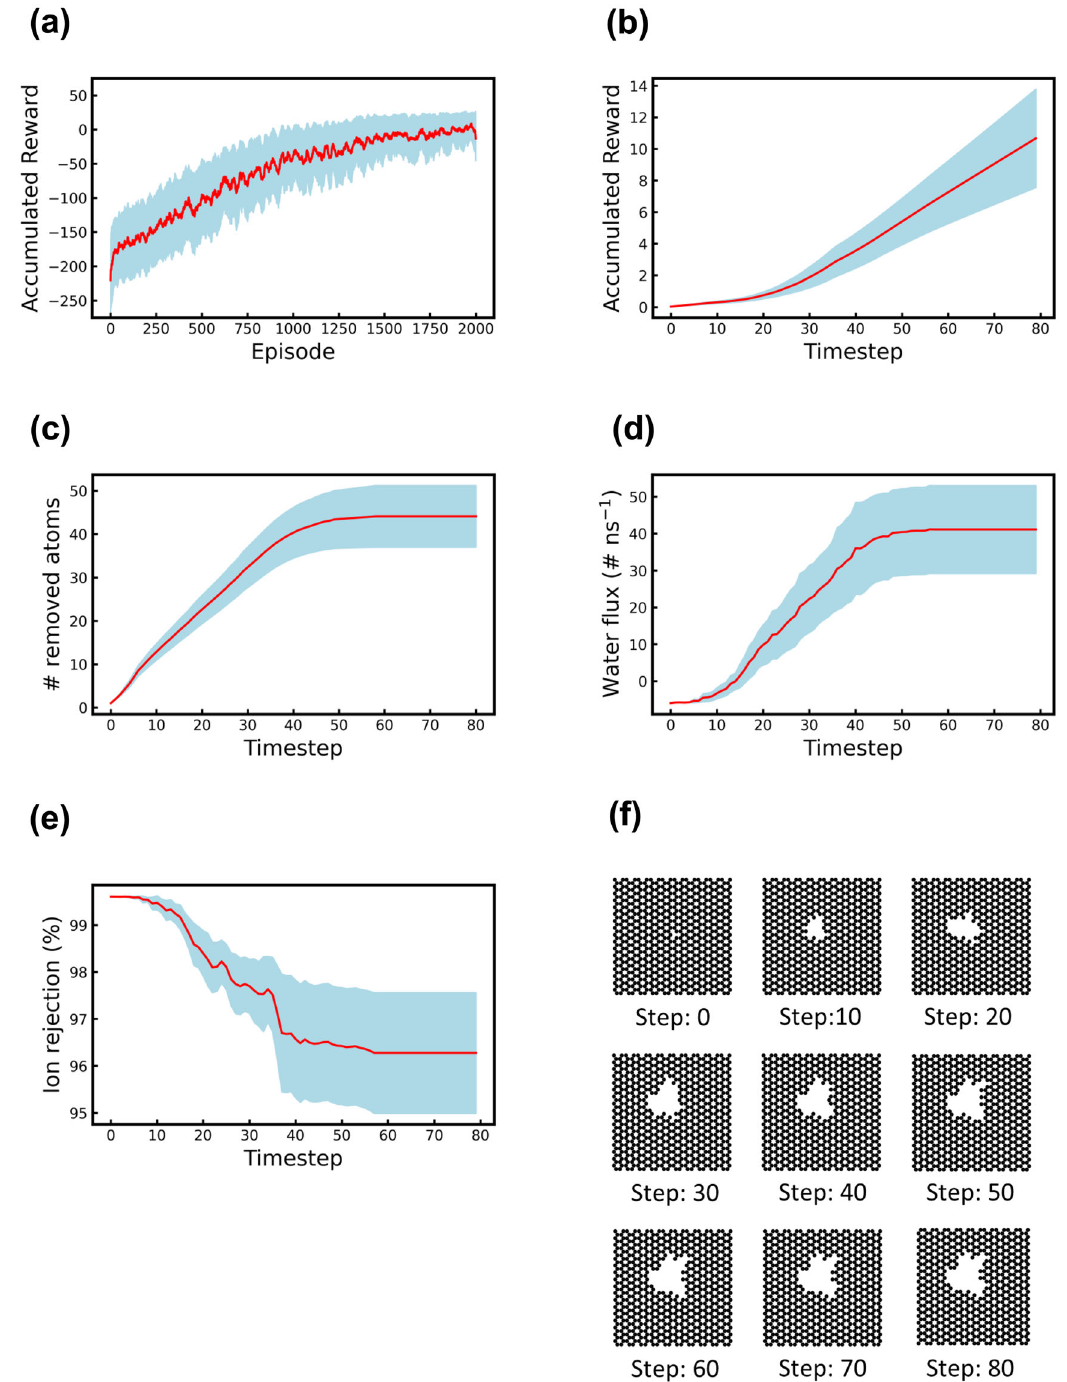
Fig. 3 Training results for 10 DRL agents. a Summation of reward in each timestep vs. episode, where the red line is the running average of the reward with window size 21 and the blue shadow represents the standard deviation. b Summation of reward in each timestep vs. timestep. c Number of removed atoms vs. timestep. d Predicted water fl ux vs. timestep. e Predicted ion rejection vs. timestep. b – e show the results of DRL agents after trained for 2000 episodes, where the red line indicates the mean and the blue shadow is the standard deviation. f Evolution of a graphene nanopore designed by DRL edge of pore were picked based on the rank of their proximity to c t , the agent learned to pick the action aiming to maximize future the pore center, if the number exceeds M , only the fi rst M atoms rewards. closest to the center of pore were selected. However, when the We optimized the DRL agent via deep Q -learning 16 with number of edge atoms was less than M , non-edge atoms closest experience replay with 10 random seeds to generate various to the center of pore were selected as possible candidates to graphene nanopores. In the DRL agent training processes with maintain the size of c t . Given the state s t , reward r t , and candidate different random seeds (Fig. 3), the red curves indicate mean